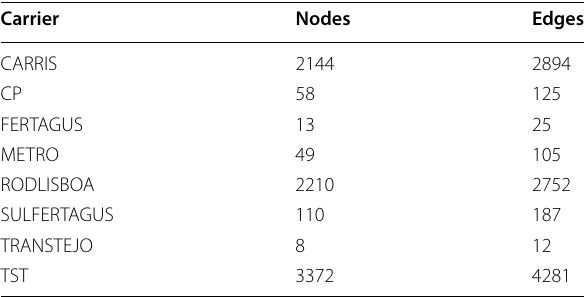
Table 2 The number of edges and nodes for each transport operator.